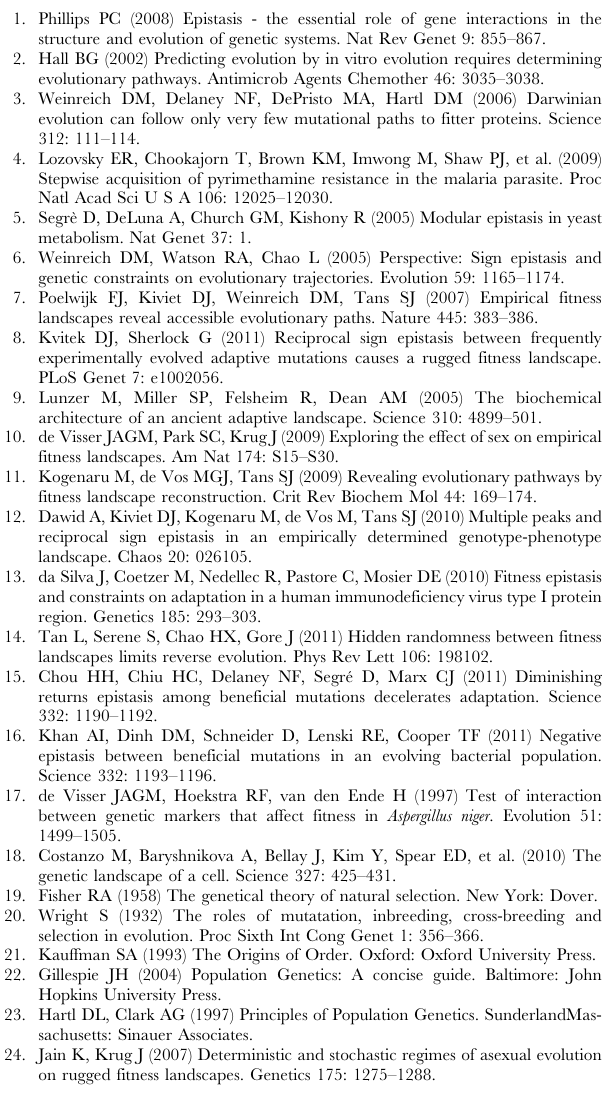
Table S1 Mean fitness W (mycelium growth rate) of the 186 segregants of A. niger relative to that of the wildtype strain with the olv marker. Presence or absence of marker mutations is indicated with 1 and 0, respectively. Missing genotypes are marked with m